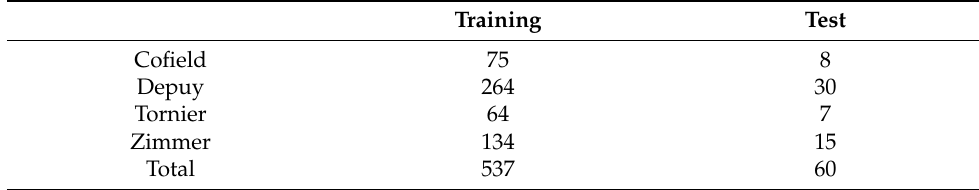
Table 2. Use of the dataset in the application.